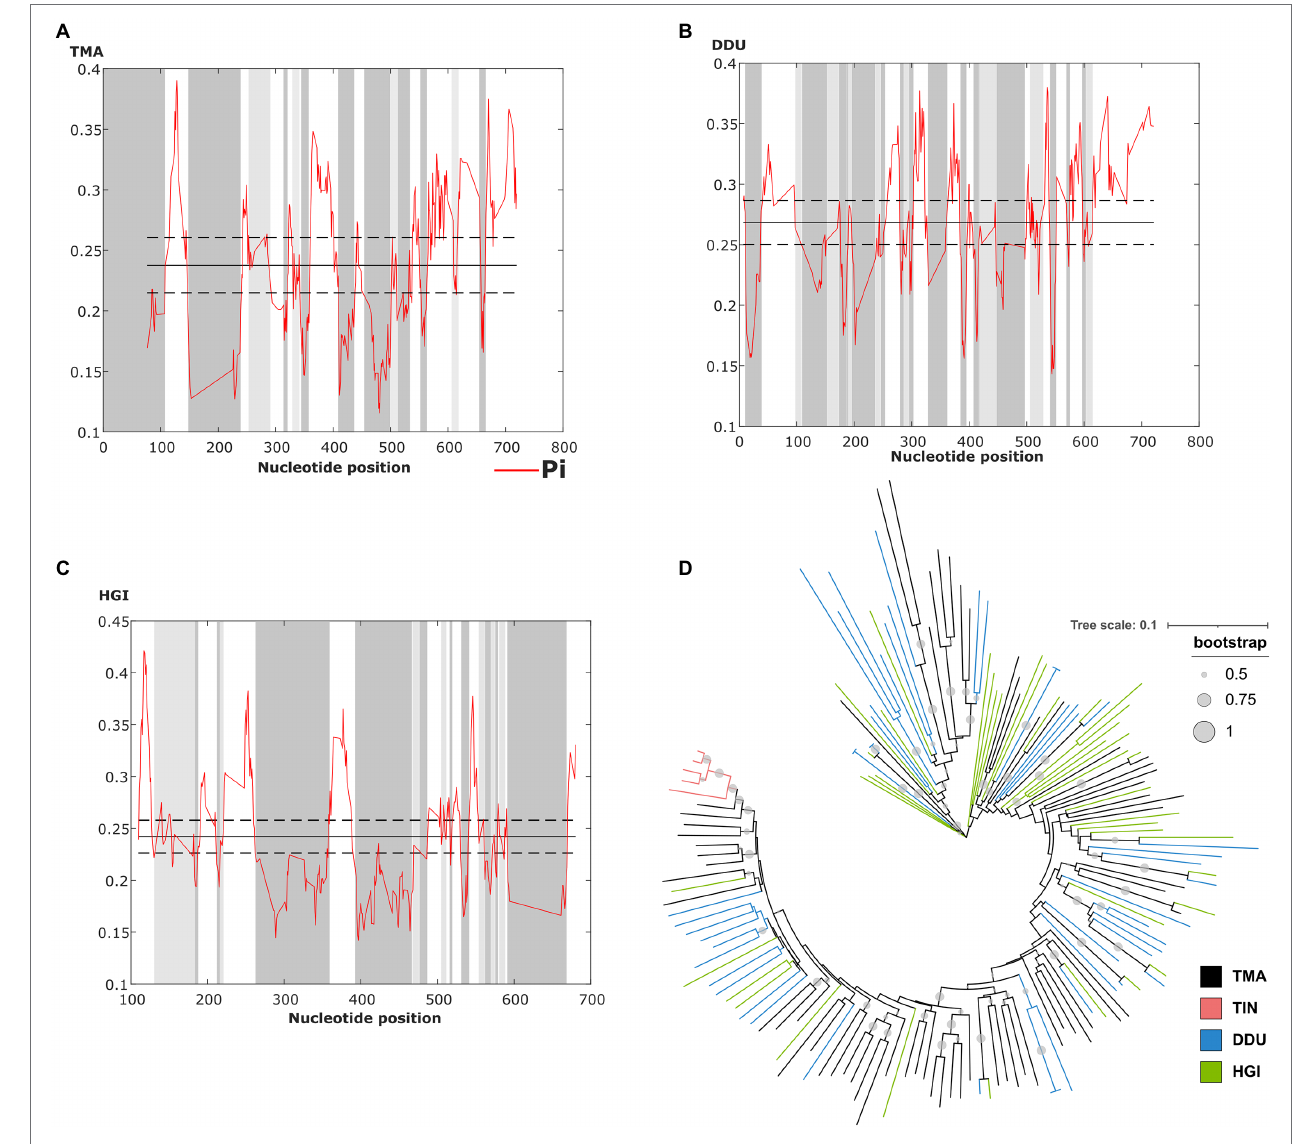
FIGURE 3 | Identification of conserved and variable TMAsat segments of (A) T. manatus , (B) D. dugon and (C) H. gigas by sliding window analysis (sliding window of 10 bp and step size of 1 bp). Average nucleotide diversity (Pi) is indicated by the red line, while average nucleotide diversity is indicated by the solid line, and average diversity ± 2 SD is indicated by the dashed line. (D) Neighbor-joining tree with TMAsat sequences of T. manatus (TMA), T. inunguis (TIN), D. dugon (DDU), and H. gigas (HGI). Bootstrap values generated from 500 replicates.